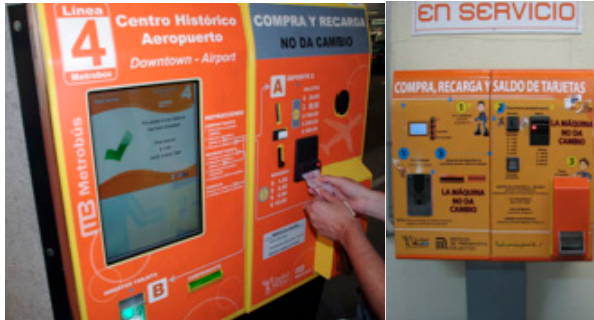
Figure 7. General overview and detailed closeup of Metrobús ticket vending machine in Mexico City bus terminal, Mexico.